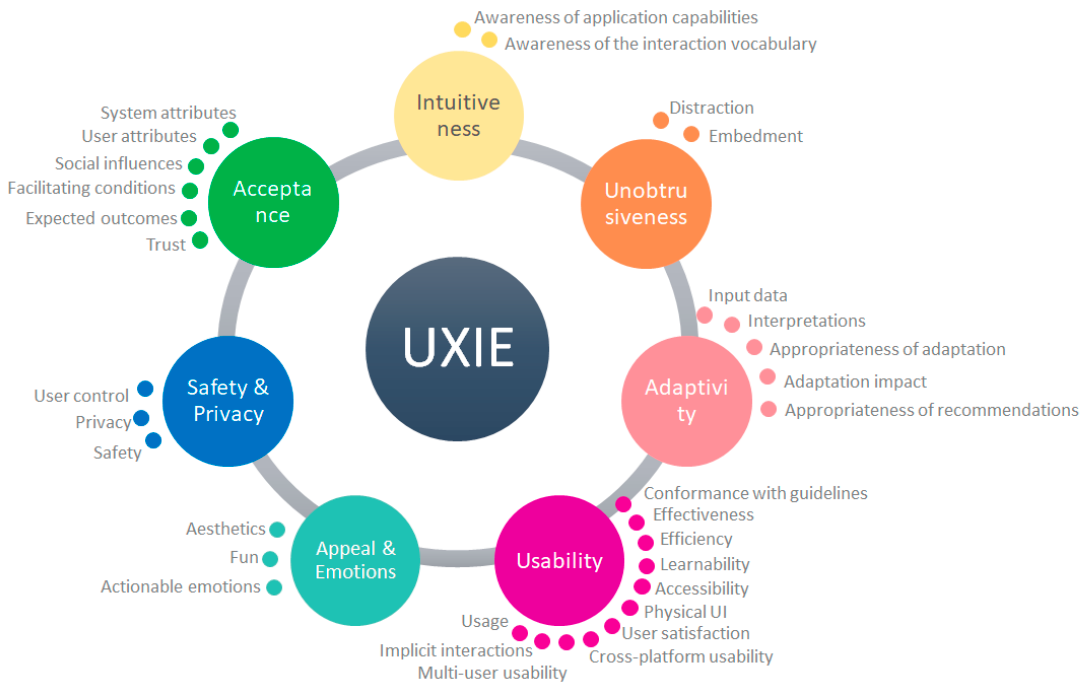
Figure 2. Attributes and characteristics of intelligent environments in the UXIE framework.